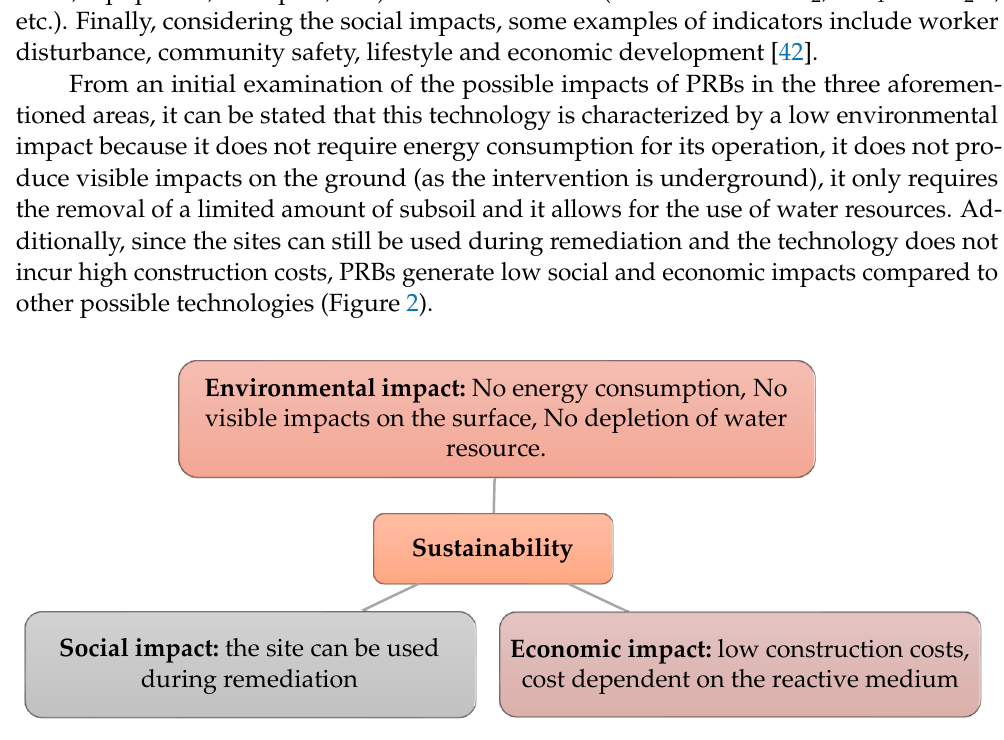
Figure 2. The environmental, economic and social impacts of PRBs.